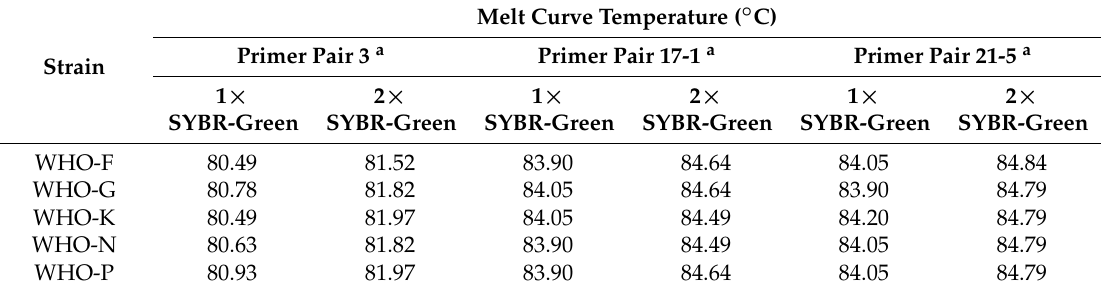
Table 3. The effect of SYBR-Green concentration on melt curve temperature (Tm values) of five N. gonorrhoeae strains, with primer pairs 3, 17-1, and 21-5.